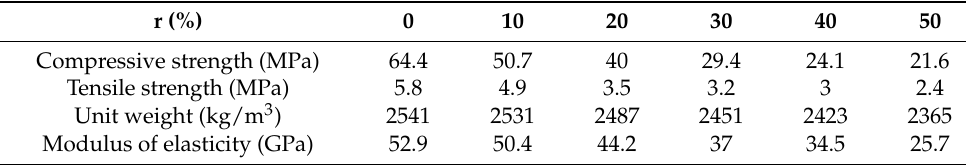
Table 3. Rubberized concrete